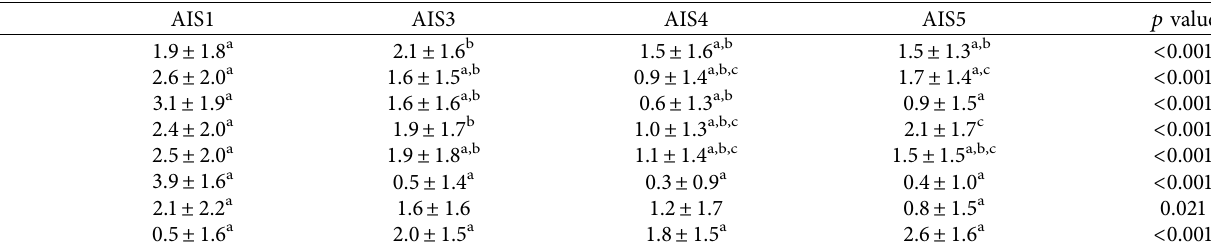
Table 2: Te correlation between injury mechanisms and injury